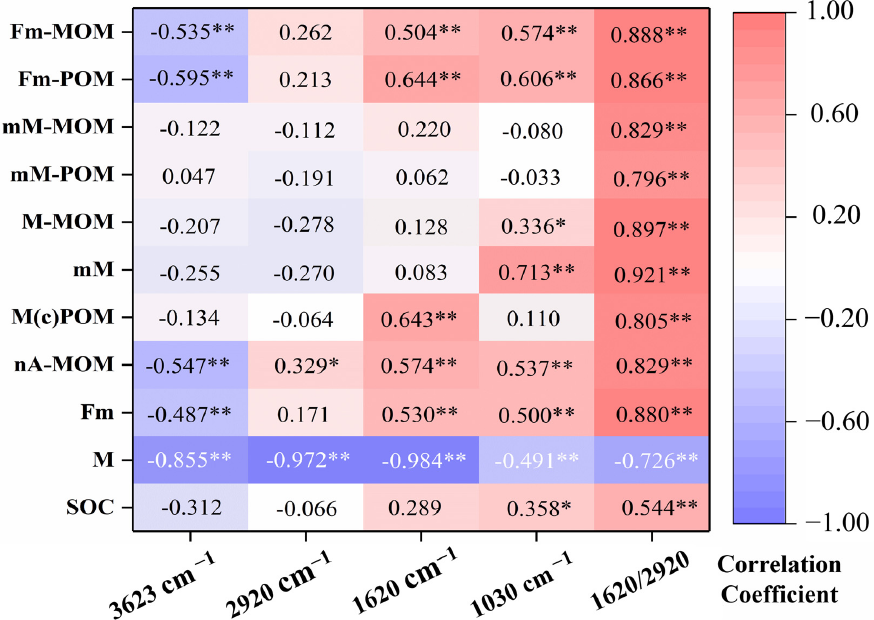
Figure 8. Correlation analysis between the relative area of infrared absorption peak and organic carbon content in bulk Mollisols and aggregates sizes. * p < 0.05, ** p < 0.01, n = 36. The specific meanings of organic matter and organic carbon fractions with abbreviations are presented in Table